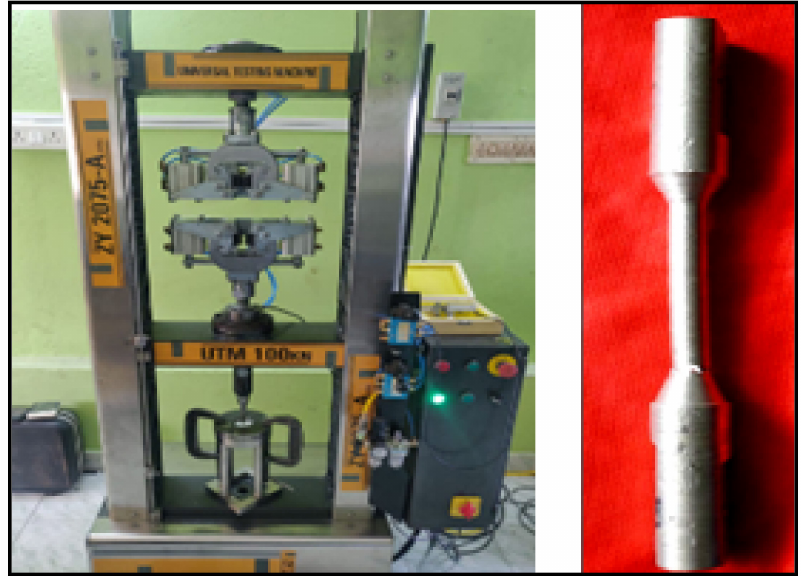
Figure 3. Schematic view of 100 kN capacity of UTM with tensile test specimen.